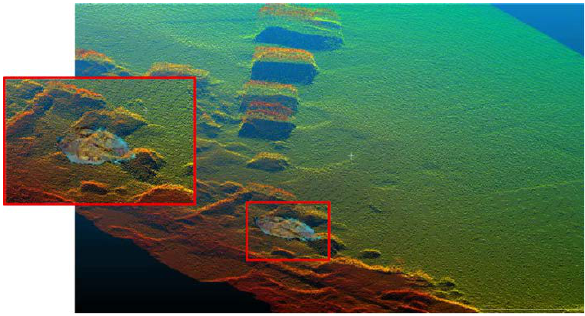
Figure 6. Opto-acoustic alignment of the fishpond